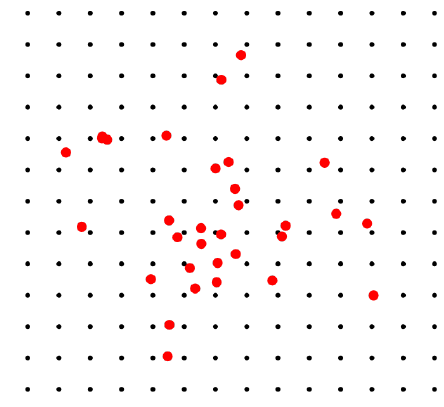
Figure 10. Interpolation of air quality data; red dots: where pollution is measured; black dots: where it is